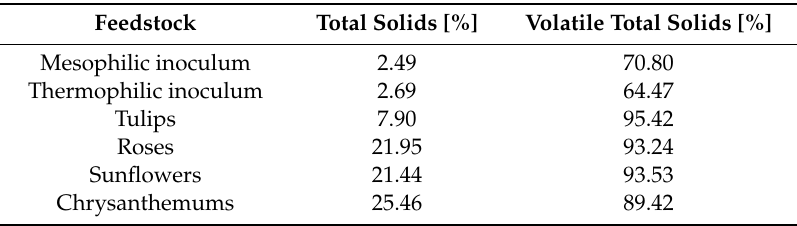
Table 2. Results of physical and chemical properties for tested feedstock. Feedstock Total Solids [%] Volatile Total Solids [%] Mesophilic inoculum Thermophilic inoculum Tulips Roses Sunflowers 21.44 93.53 Chrysanthemums 25.46